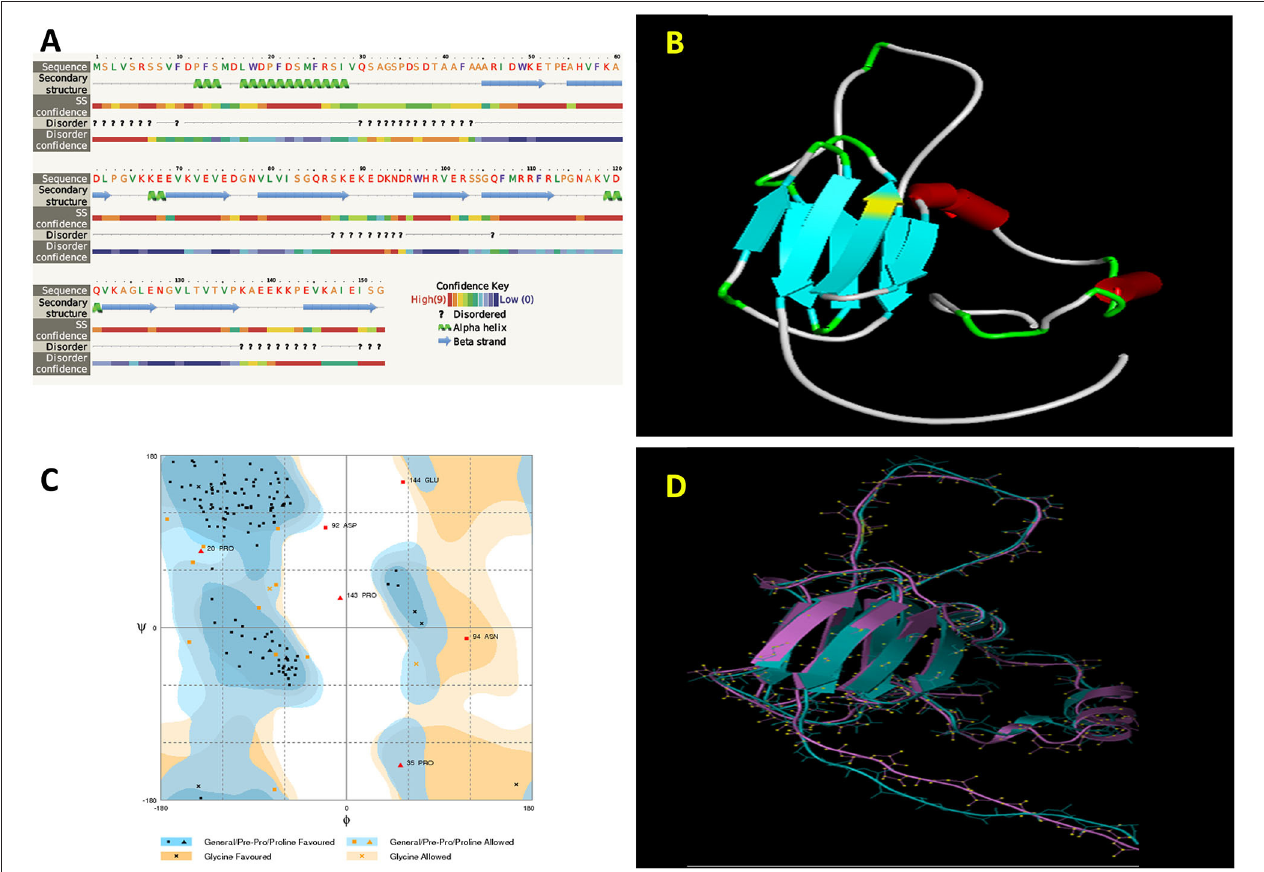
FIGURE 5 | Geometrical and three-dimensional (3D) structural analysis of PgHSP16.97 protein (A) . Secondary structure analysis of PgHSP16.97 has been shown by using the Phyre2. (B) Predicted 3D structure of PgHSP16.97 given by the modeler 9v11 showing the arrangements of alpha and beta chains. (C) Ramachandran plot of PgHSP16.97 generated by Rampage showing dihedral (phi and psi) angles in which favored region marked as dark blue and orange and allowed regions marked as light blue and orange shades whereas the residue on white spaces are the outliers. (D) Structural superimposition between model and template protein (1GME) given by STRAP (Blue: Template and Violet: model) (https://figshare.com/s/13b4394e6e6137f826ce).